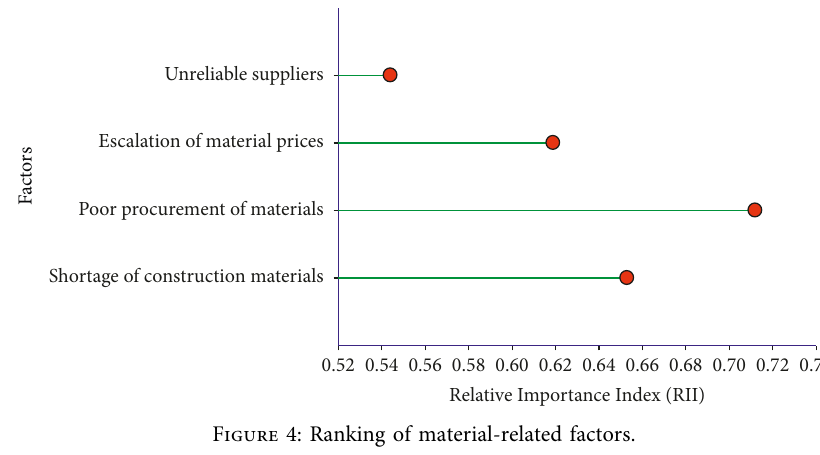
Figure 4: Ranking of material-related factors.